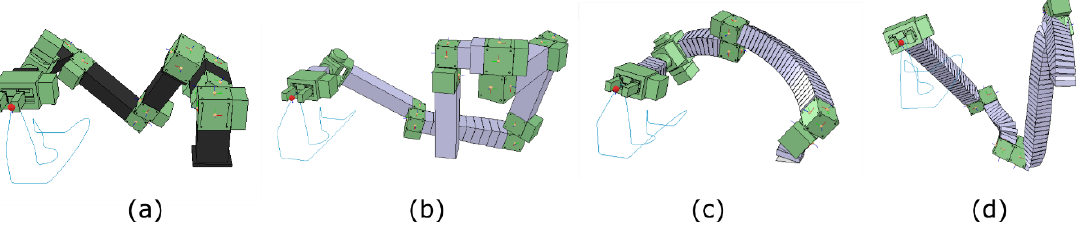
Figure 19. Best results for task 3: ( a ) basic links; ( b ) linear links; ( c ) rounded links; ( d ) Hermite spline links.